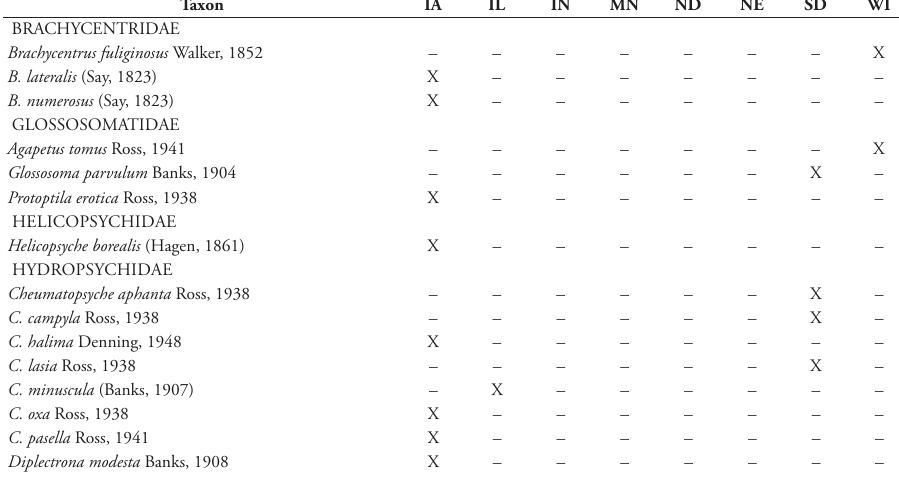
Table 1. The 131 new state species records reported herein. Species organized by family and genus. More detailed collecting data are available in Suppl. material 2. Taxon